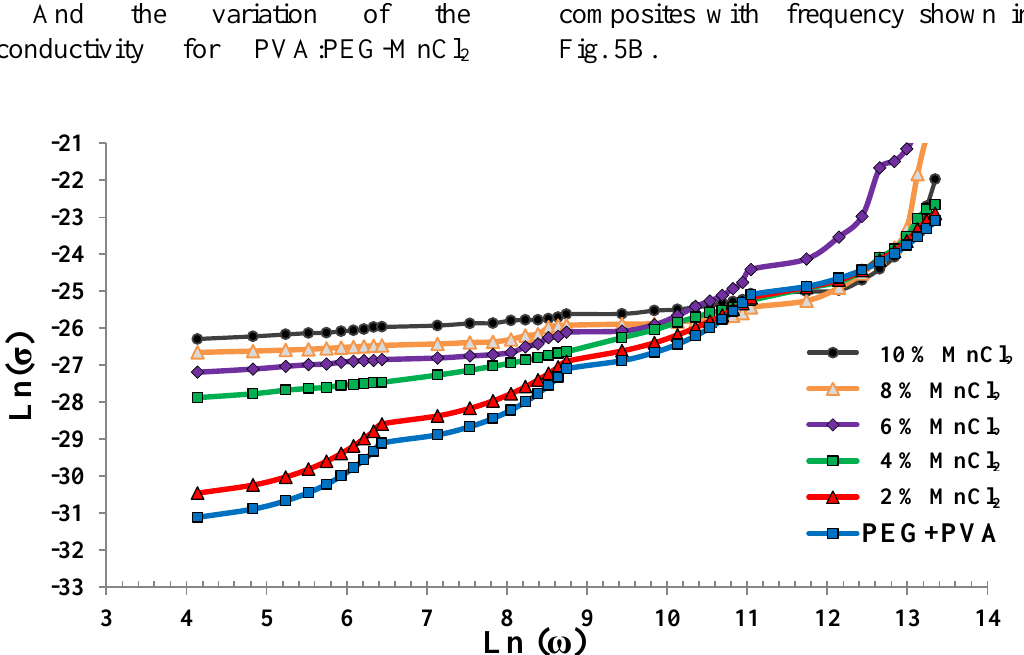
Fig. 5B: The variation of the conductivity for (PVA-PEG-PVA:PEG) composites with